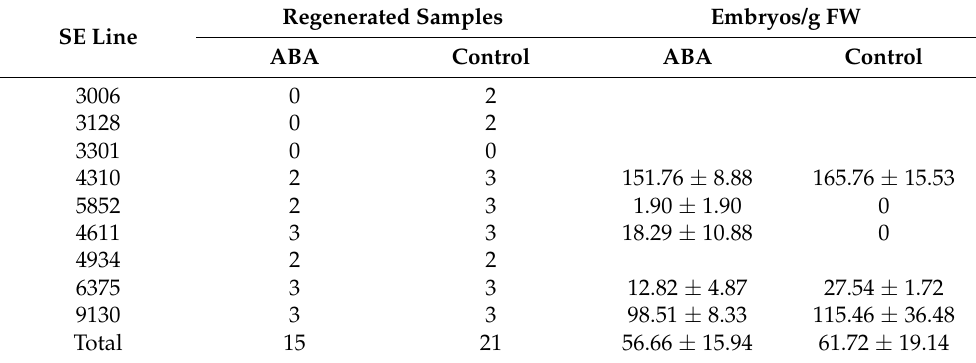
Table 1. Number of samples regenerated after cryopreservation when pre-treated with or without ABA, and embryo production capacity per one gram of fresh weight of ET. Three cryovials containing ET from the same genotype as the control and experimental media were stored in LN. Regenerated Samples Embryos/g FW SE Line ABA Control ABA Control 3006 0 2 3128 0 3301